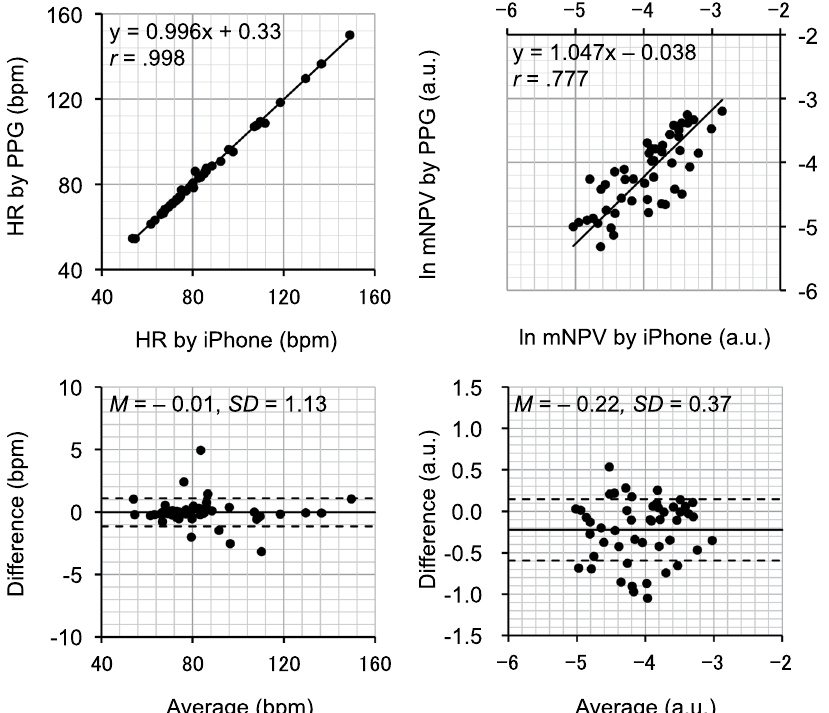
Figure 1. The agreement of heart rate (HR) and natural log transformation (ln) modified normalized pulse volume (mNPV) measurements derived from an iPhone 6s (iPhone) and a laboratory photoplethysmograph (PPG). (Upper) Solid line represents the geometric mean regression line and its formula, together with r value, is shown in each scatterplot. (Lower) Corresponding Bland–Altman plots. Solid line and dashed lines represent fixed bias ( M ) and M ± 1 standard deviation (SD) range, respectively. Average = (iPhone + PPG)/2, Difference = PPG – iPhone. N = 49.